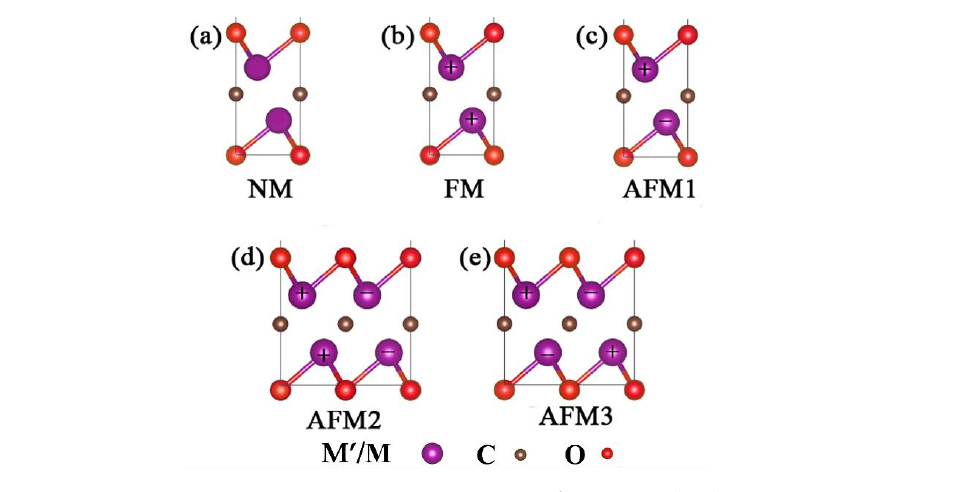
Figure 3. M’MCO 2 magnetic state configurations: ( a – e ) represent NM, FM, AFM1, AFM2, and AFM3 configurations, respectively. In M’/M atoms, “+” represents spin-up and “ − “ represents spin-down.